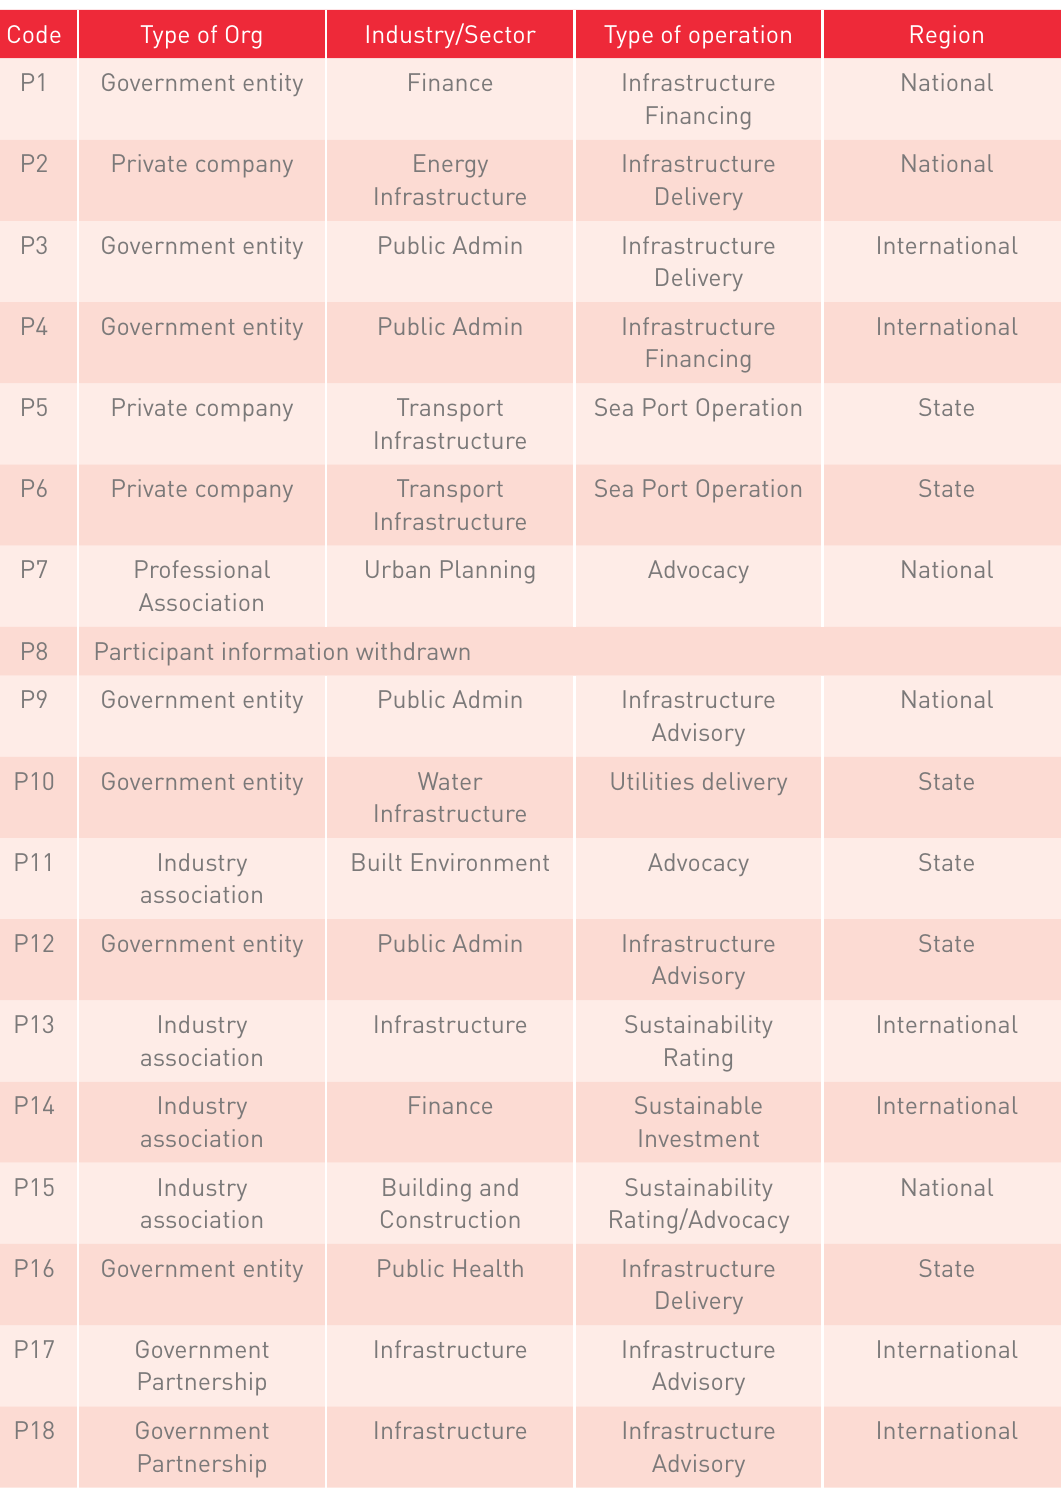
Table 1. Interview